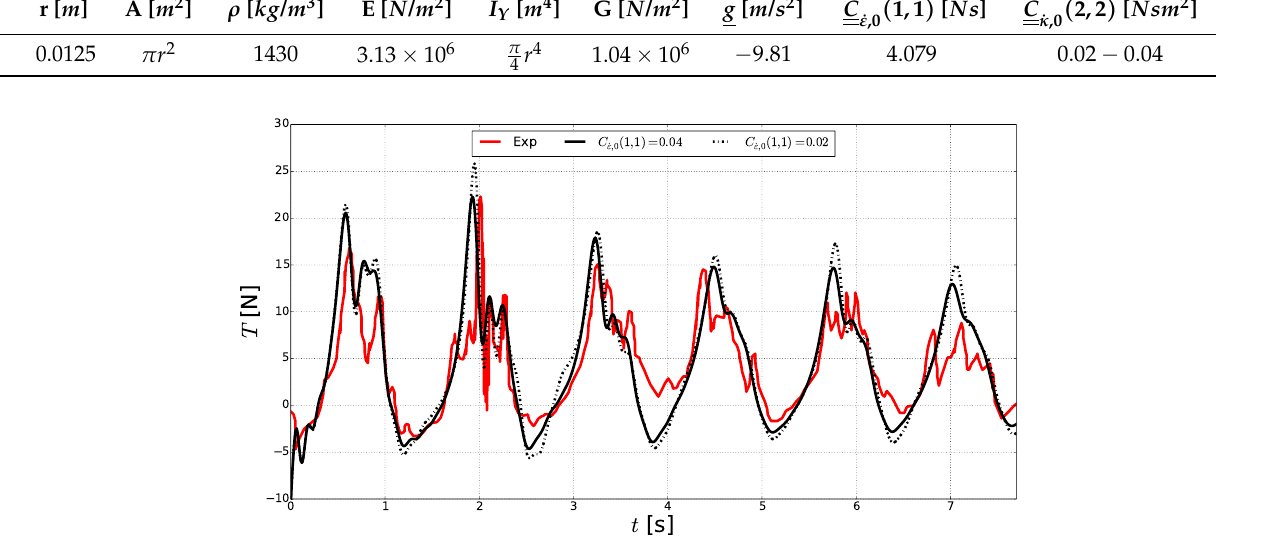
Figure 10. Tension force distribution over time close to the pin for the swinging elastic hanging rod.